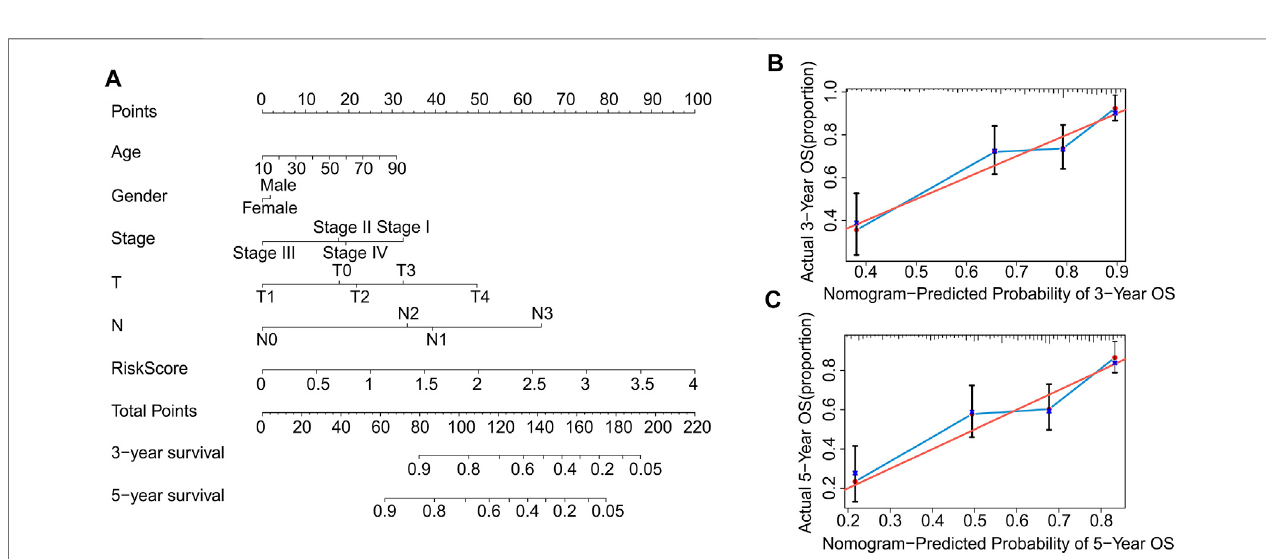
FIGURE 7 | Construction and validation of prognostic nomograms based on risk scores of autophagy-related lncRNAs prognostic signatures. (A) Construction a nomogram using risk scores and other clinicopathological parameters (age, gender, stage, T stage, and N stage) to predict 3- and 5-years survival rate of CM patients. Calibration curve reveals the accuracy between predictive power and actual survival of (B) 3- and (C)